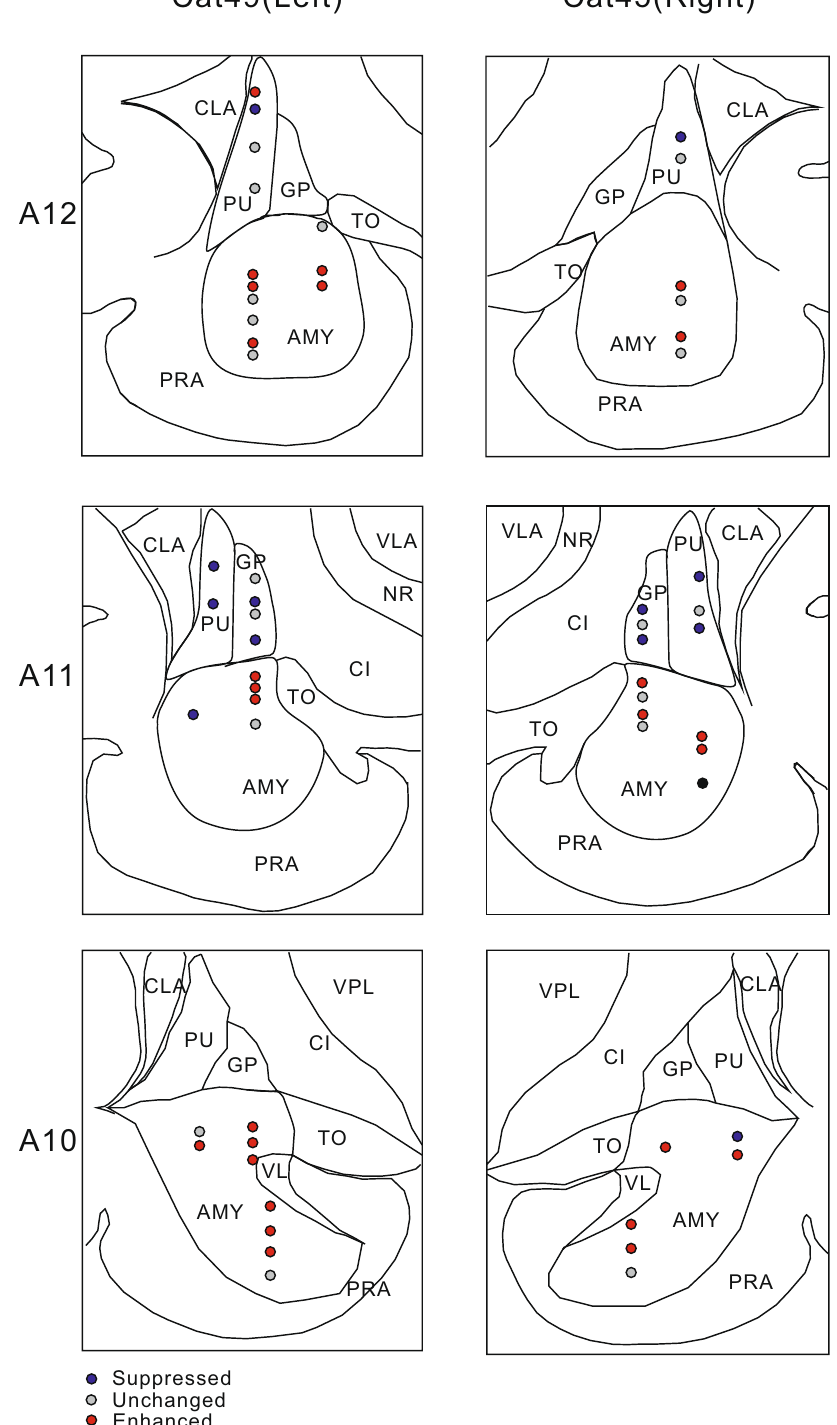
Figure 2. Reconstruction of the locations of recorded units in the AMY and STR of two representative cats. A10, A11, and A12 were 10, 11, and 12 mm anterior to the interaural plane, respectively. Different symbols mark the location of different groups of units. AMY: amygdala; CI: capsula interna; CLA: claustrum; GP: globus pallidus; NR: nucleus of reticularis thalamus; PRA: cortex of pariamygdalae; PU: putamen; STR: striatum; TO: tractus opticus; VL: lateral ventriculus; VLA: lateral ventral thalamus; VPL: posterior lateral ventral